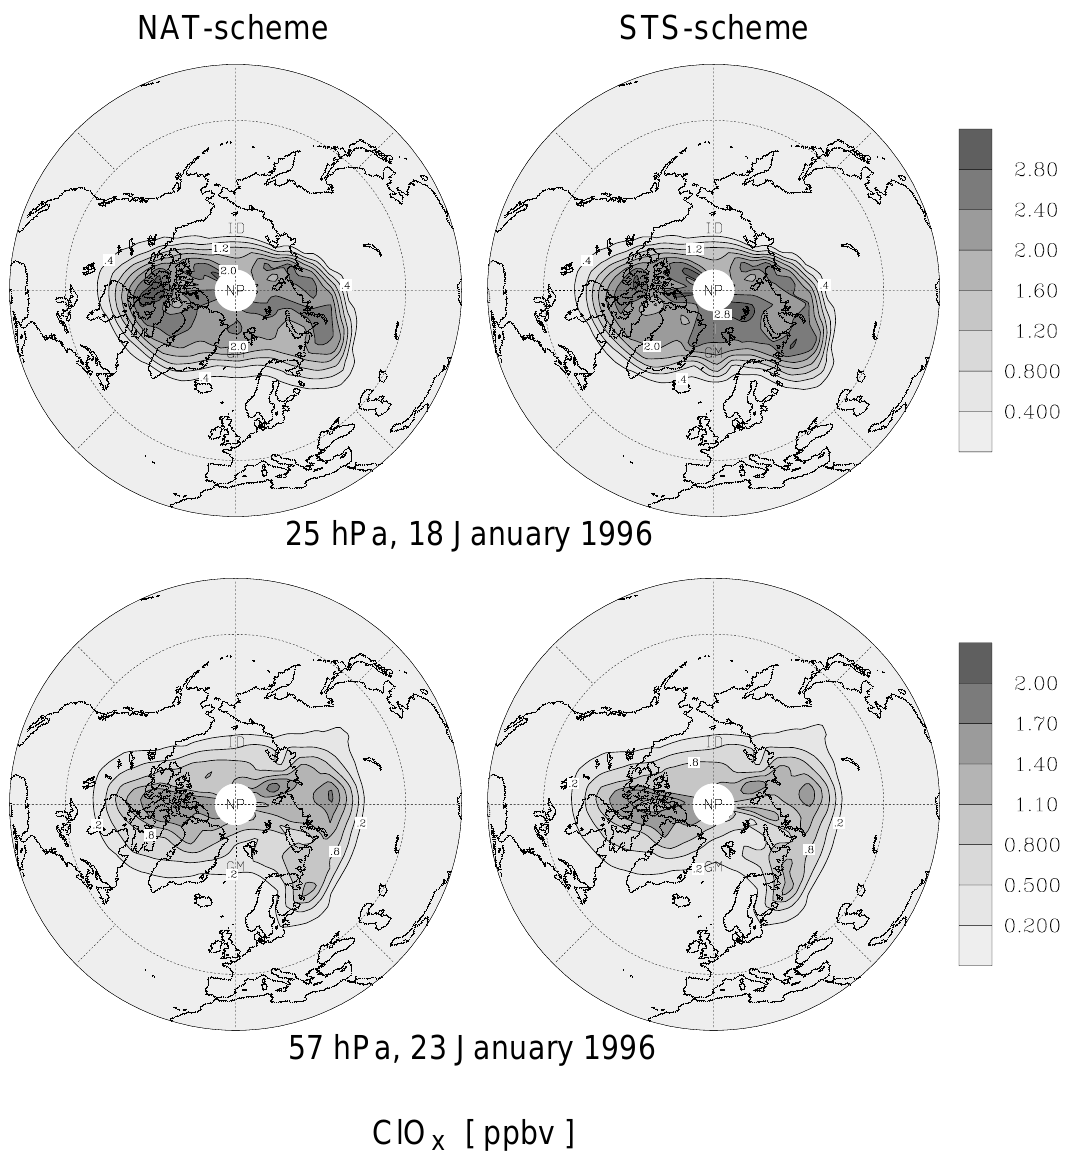
Fig. 7. ClO x (: = Cl+ClO+2 Cl 2 O 2 +2 Cl 2 +HOCl+OClO) mixing ratio (ppbv) modelled for (top frames) the 25 hPa and (bottom frames) the 57 hPa levels. Results are shown for two selected days of January 1996 showing comparatively large chlorine activation (57 hPa level on 23 January 1996, and 25 hPa level on 18 January 1996). The left frames and right frames show data modelled applying the NAT- and the STS-scheme,